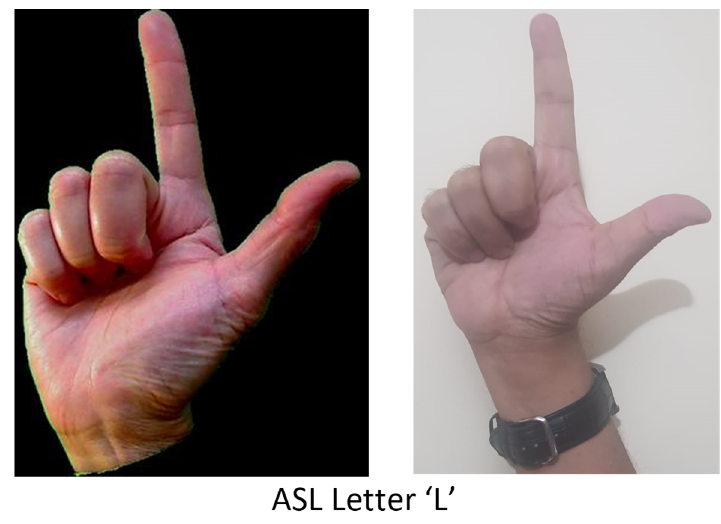
Figure 21. Detecting other objects—wristwatch scenario 2.